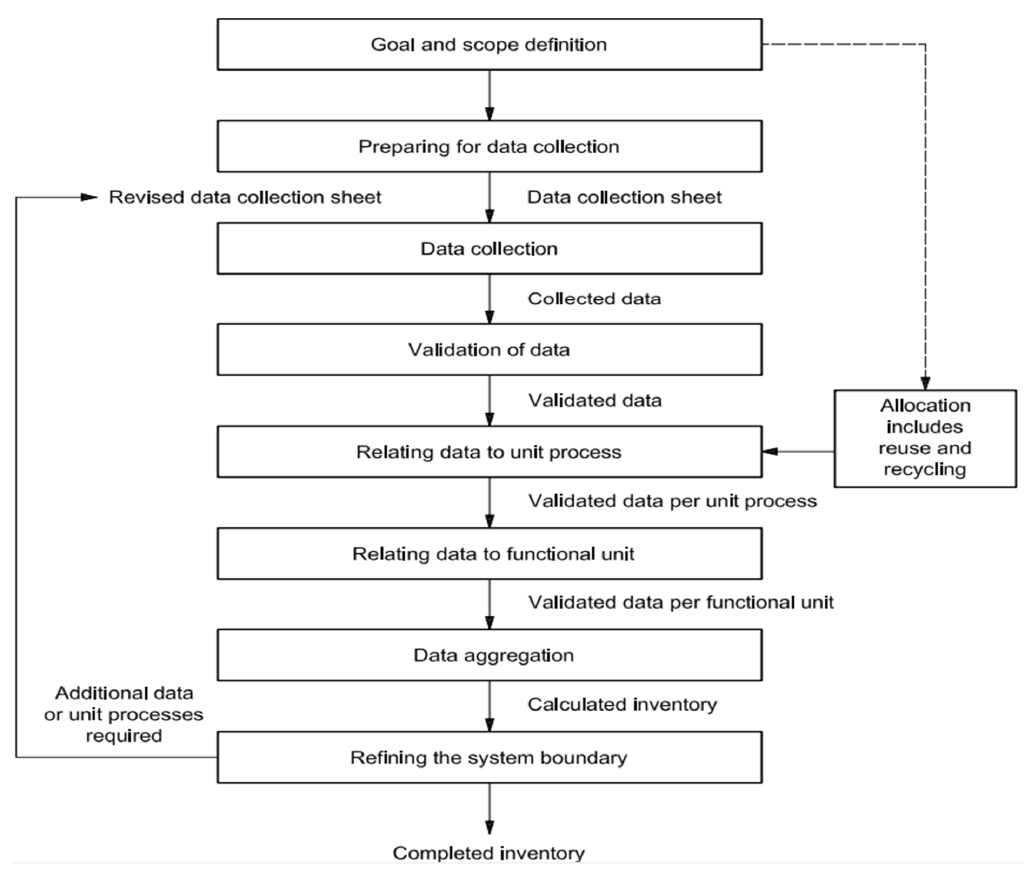
Figure 2. Simplified procedures for Life Cycle Assessment (LCA) inventory analysis [50].